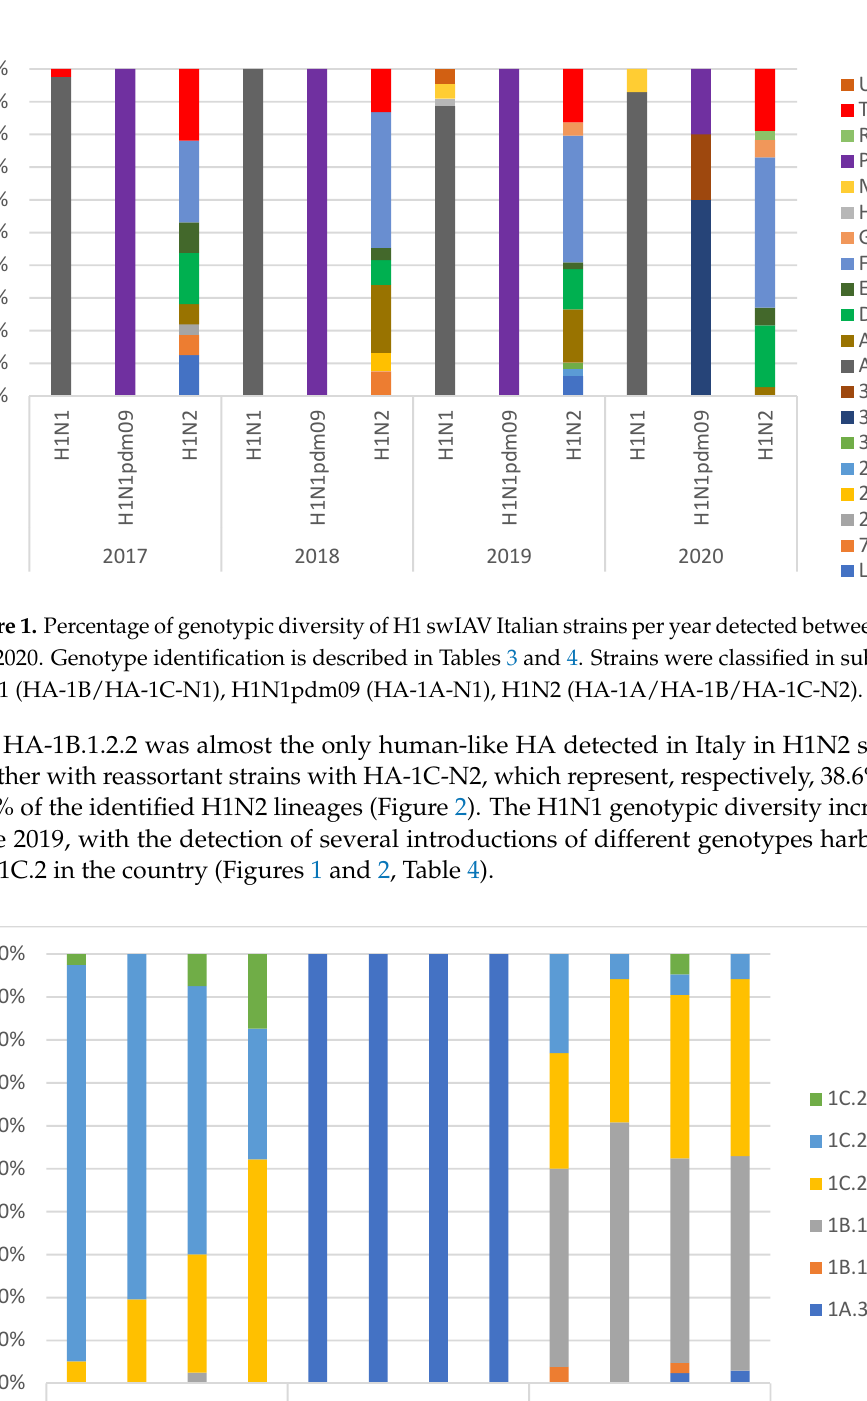
Figure 2. H1 lineage differentiation per year of collection of swIAVs detected. H1 nomenclature was applied as described by Anderson et al. Strains were classified in subtypes: H1N1 (HA-1B/HA-1C- N1), H1N1pdm09 (HA-1A-N1), H1N2 (HA-1A/HA-1B/HA-1C-N2).